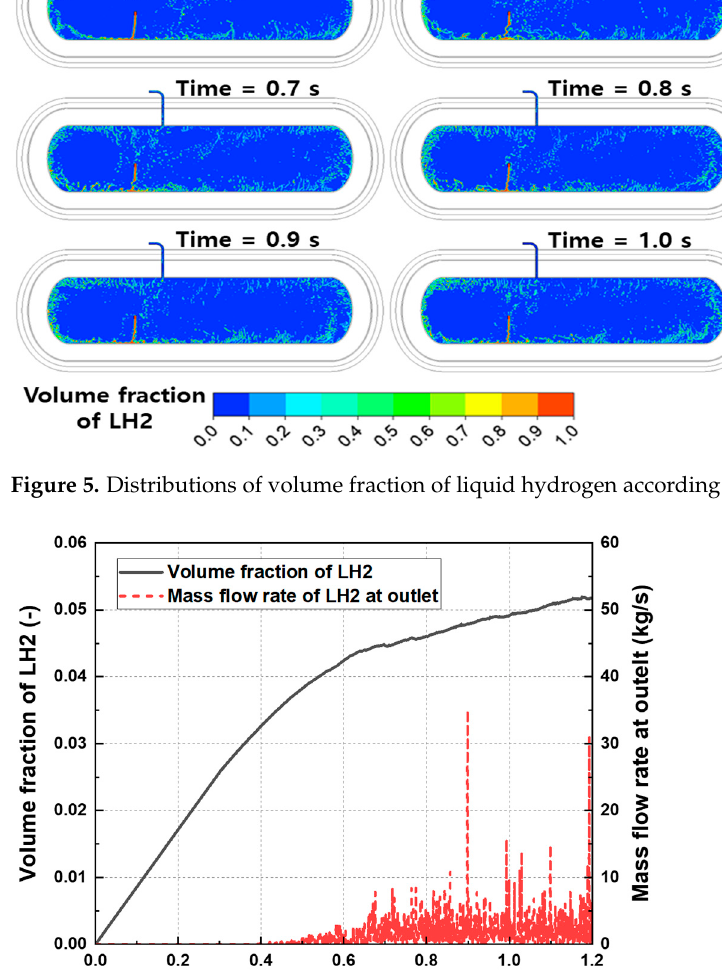
Figure 5. Distributions of volume fraction of liquid hydrogen according to charging process.